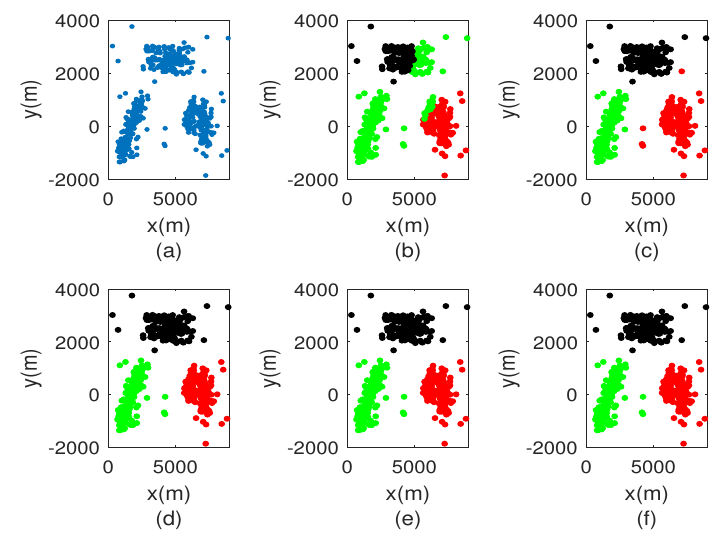
Figure 3. Comparison of classification results. ( a ) original data set; ( b ) sampling rate is 1%; ( c ) sampling rate is 10%; ( d ) sampling rate is 50%; ( e ) sampling rate is 70%; ( f ) sampling rate is 100%.